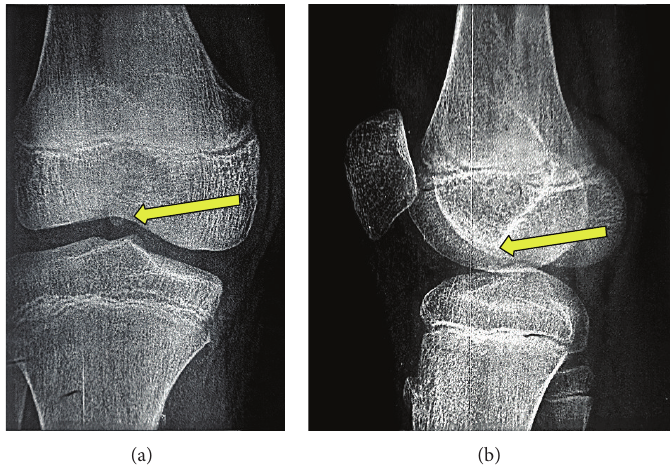
Figure 1: X-ray: (a) AP view and (b) lateral view showing what appeared to be a foreign body in the joint.